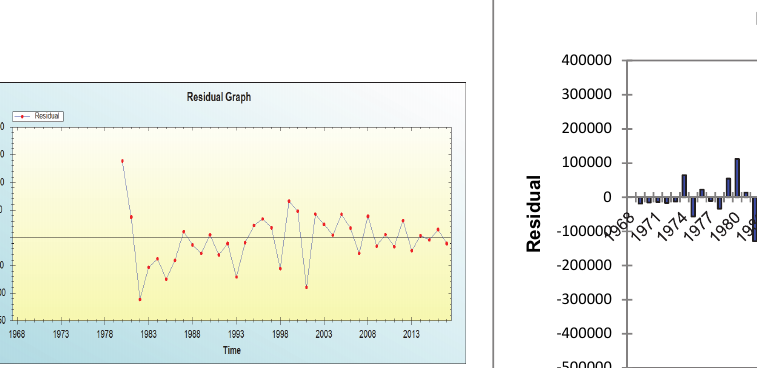
Fig. 12 . Residual graph of export using neural network